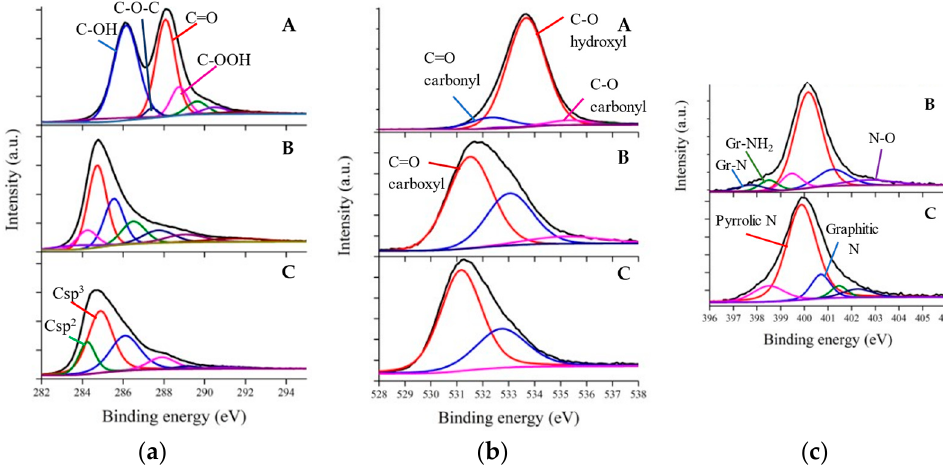
Figure 3. Deconvoluted XPS spectra of the ( a ) C1s ( b ) O1s and ( c ) N1s region of (A) GO, (B) Ppy-rGO, and (C) MOFs-W(OCH 2 CH 3 ) 6 /Ppy-rGO, respectively.